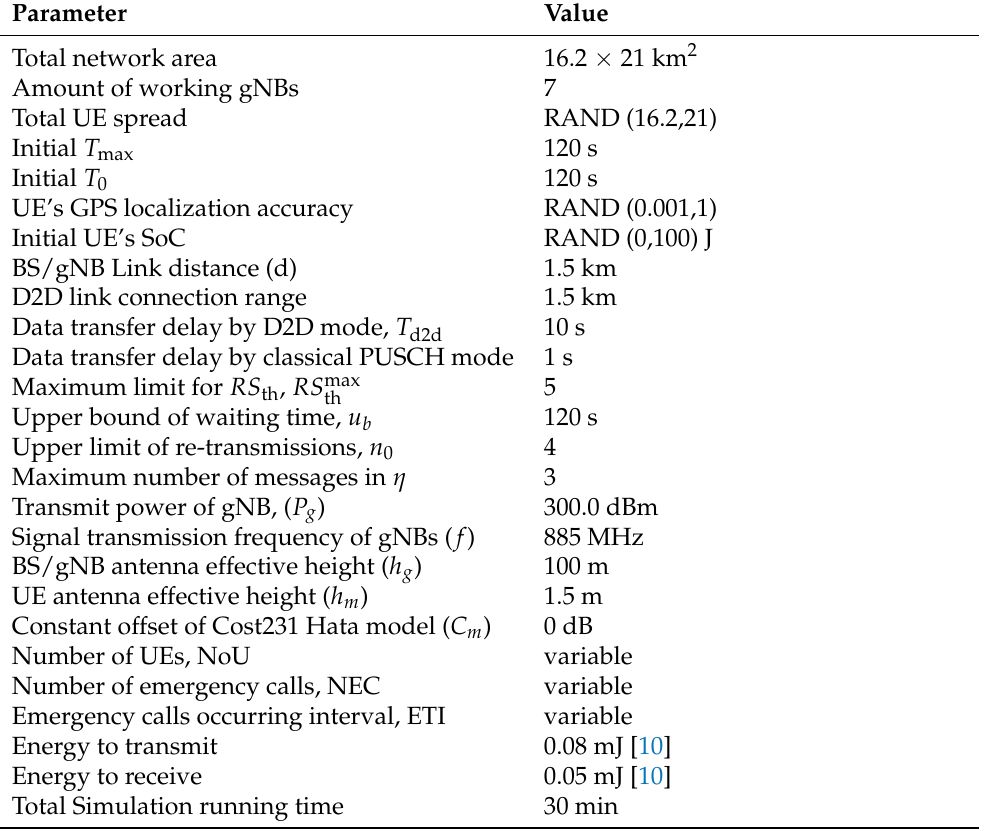
Table 5. Traverse city area emergency simulation